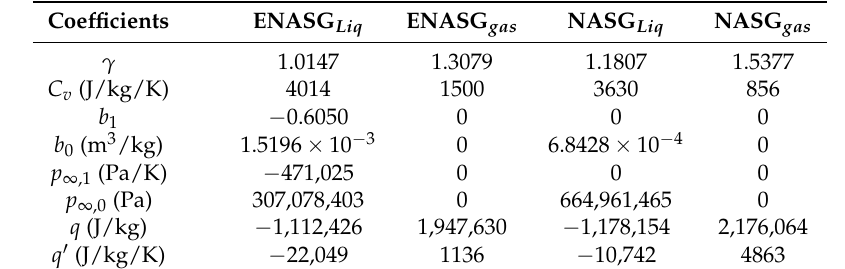
Table 1. Extended Noble–Abel Stiffened-Gas (ENASG) coefficients for water. The NASG parameters are also given and determined with the method given in Le Métayer and Saurel [14] except for the liquid reference entropy q (cid:48) that is computed with the NASG reduction of Equation (A31) (see Appendix C). The NASG water parameters are determined with n = 201 experimental saturation points in the temperature range T exp [300 K–500 K]. ∈